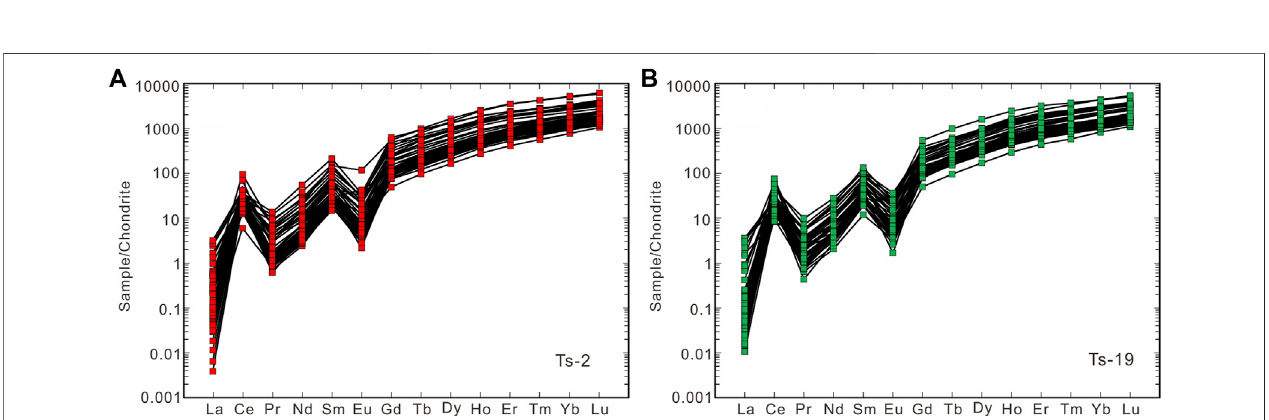
FIGURE 8 | (A,B) Chondrite-normalized REE patterns for zircons from clastic rock samples at Dengchuan. Normalized values for chondrite are from Sun et al. (1989).